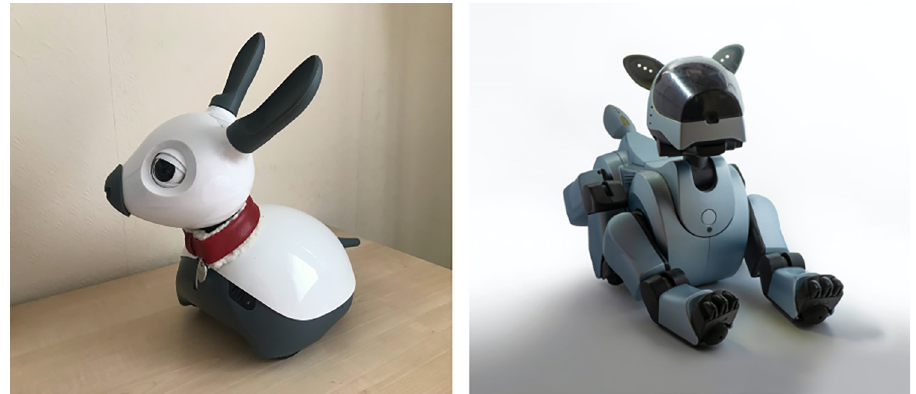
Fig 1. Images of two robots inspired by dogs, amongst other animals. The MiRo-E Robotic Platform (Consequential Robotics) and AIBO (Sony). Image credits: Katie Riddoch (author; left image) and Jeremy Bishop via Unsplash (right